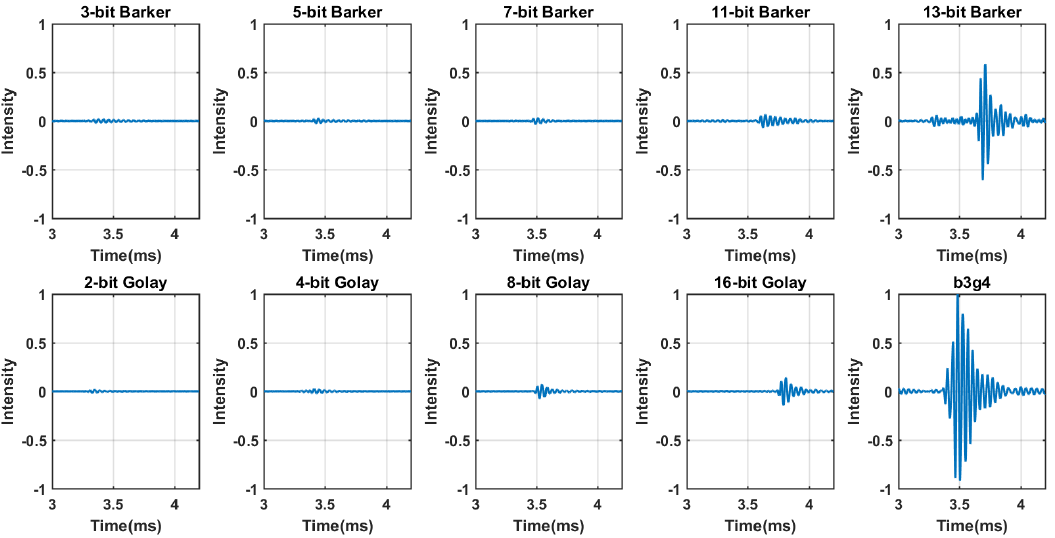
Figure 9. Comparison of results for the intensity of the Barker codes, Golay codes and BCG codes in the time domain. Please noted: The average power of the input signal for all excitation methods is the